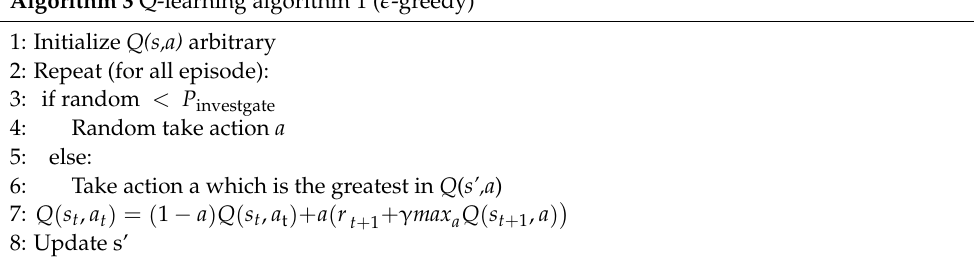
Algorithm 3 Q-learning algorithm 1 ( (cid:101) -greedy)